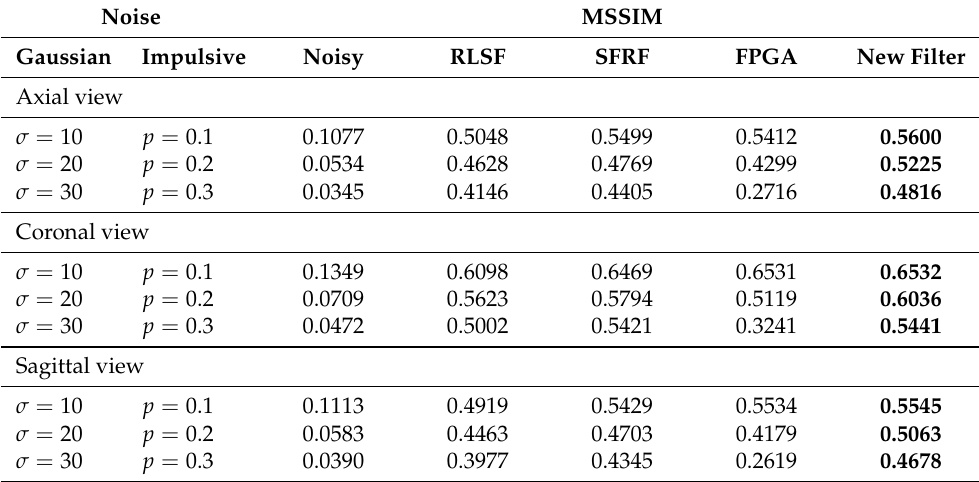
Table 3. MSSIM measure for noisy and denoised CT images. Values in bold denote the best filter- ing